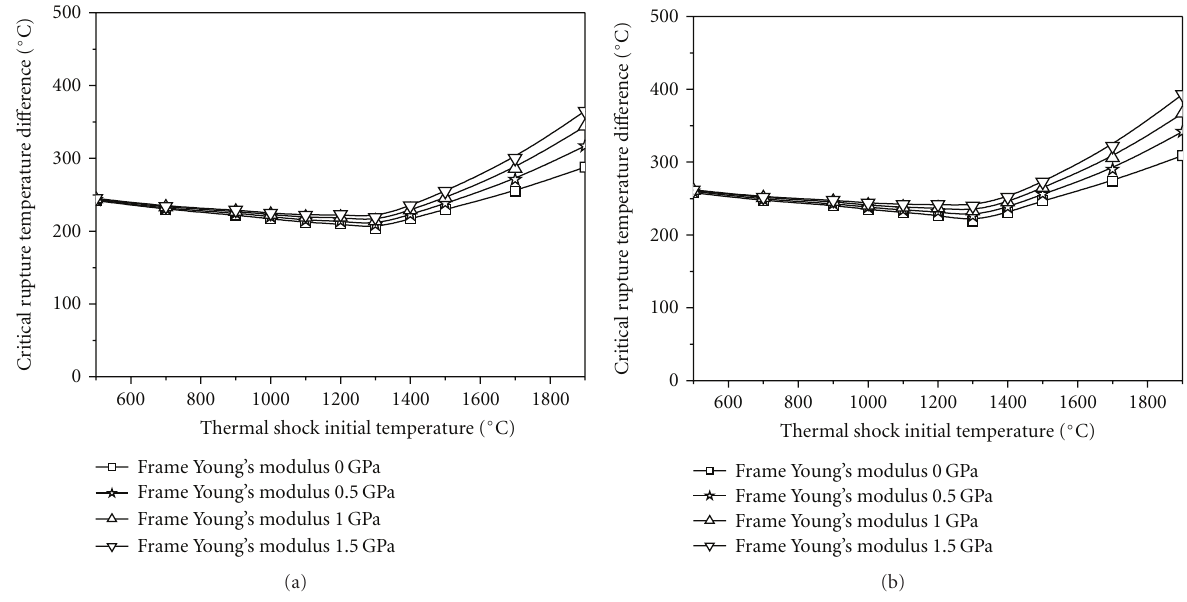
Figure 8: The critical rupture temperature di ff erence versus thermal shock initial temperature for di ff erent frame Young’s modulus with the same cooling rate (a) 320 ◦ C · s − 1 and (b) 2000 ◦ C · s − 1